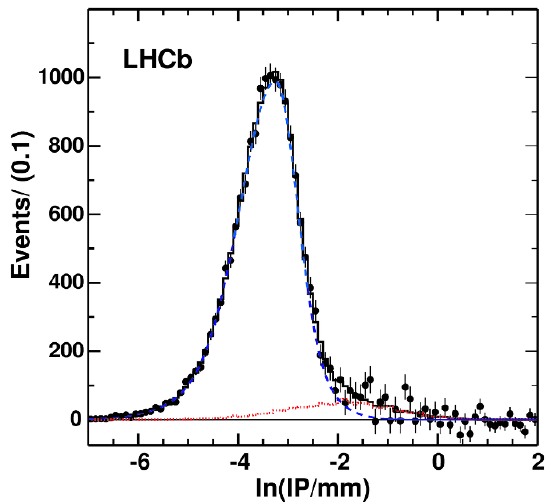
Figure 3 . Separation of prompt and displaced D 0 mesons using the IP variable [26]. The data correspond to 2 : 9 nb (cid:0) 1 of pp collisions, and contain a large prompt component (dashed line) and a smaller displaced component (dotted line). The sum of the two components is shown by a